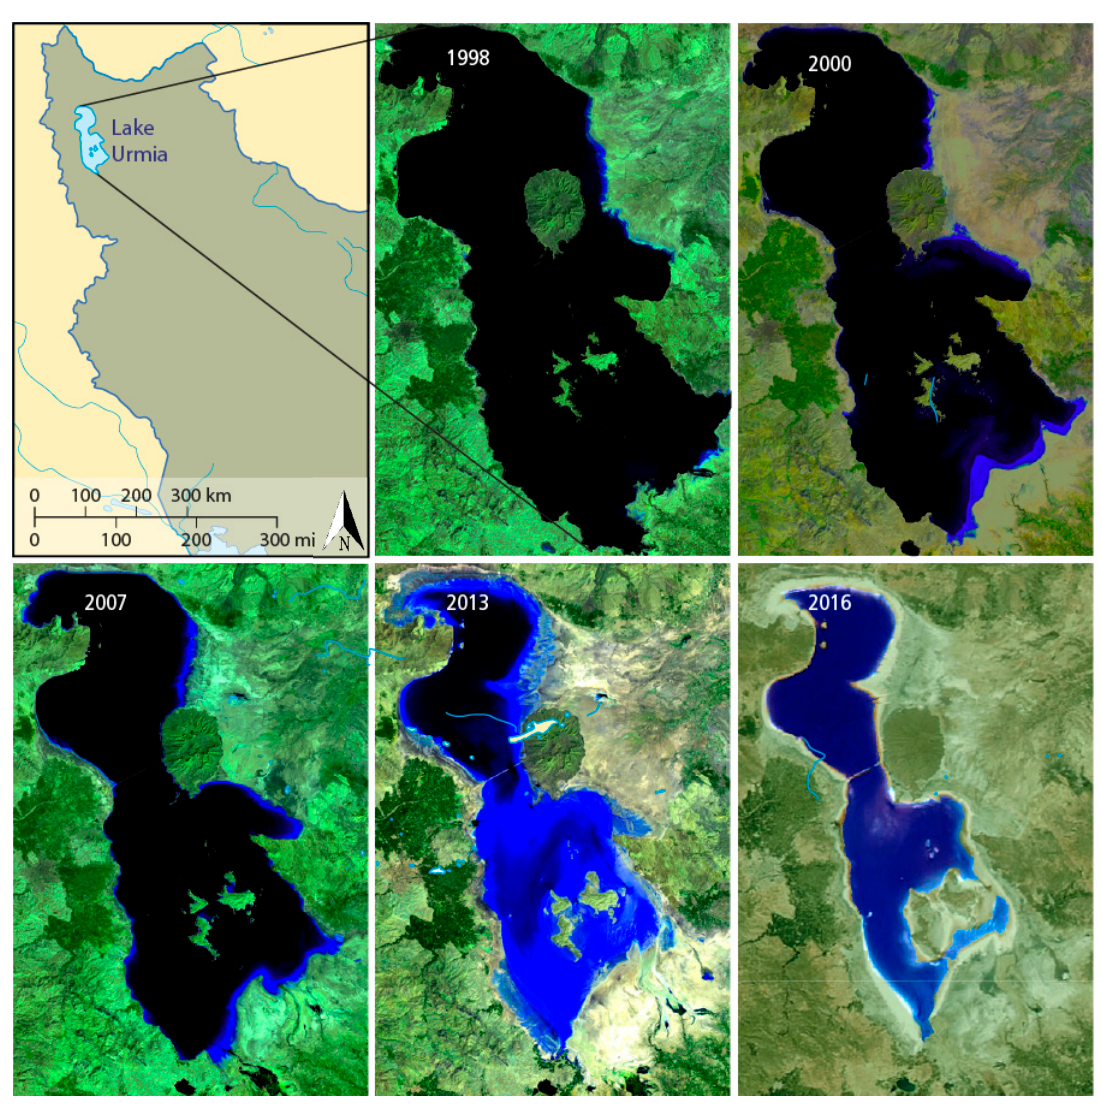
Figure 1. Lake Urmia location in the northwest of Iran and the desiccation trend between August 1998 and August 2016 [39].